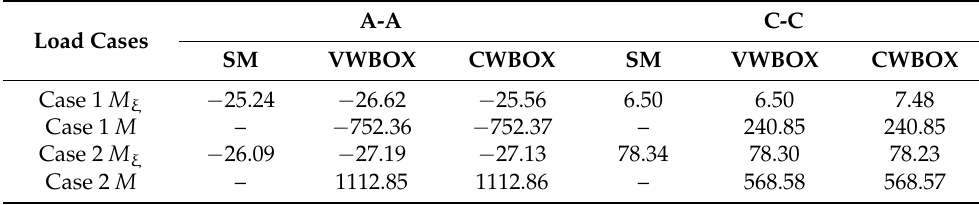
Table 3. Internal moment of mid-span and middle support of CBG-CSWs (uint: kN · cm). Load